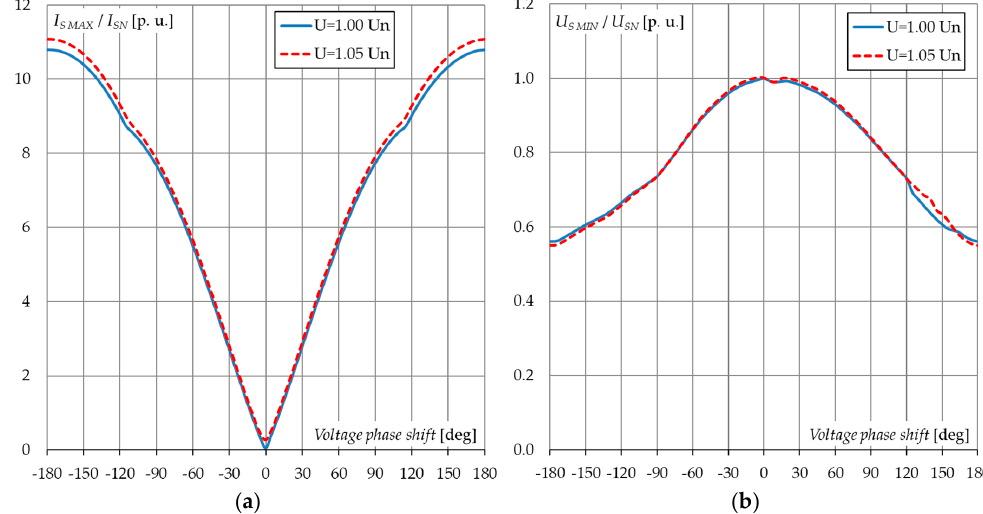
Figure 7. Maximum amplitude of stator current ( a ) and minimum amplitude of stator voltage ( b ) during the first period of faulty synchronization.